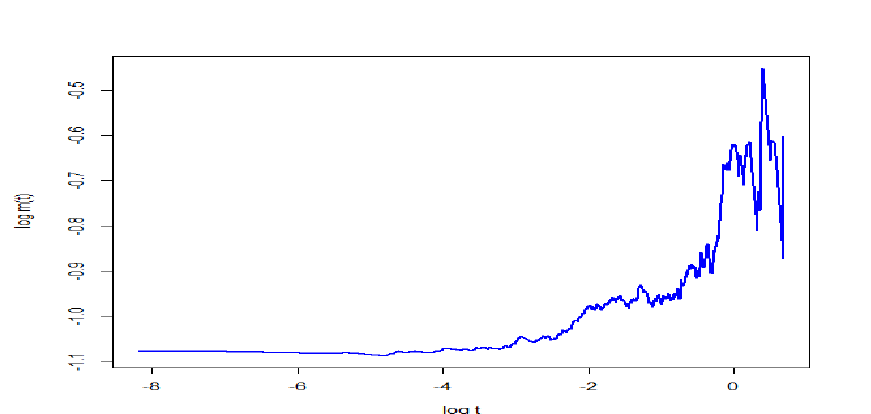
Figure 4. Graph of log mean excess function of scaled log returns of daily CRIX during 31 July 2014–1 January